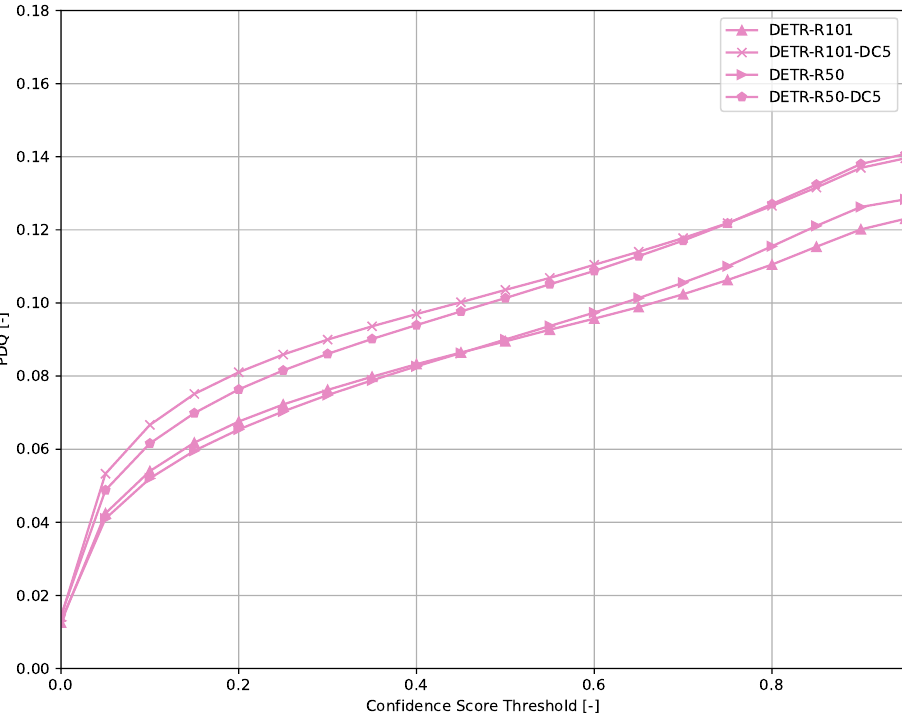
Figure 7. PDQ results of DETR on the COCO